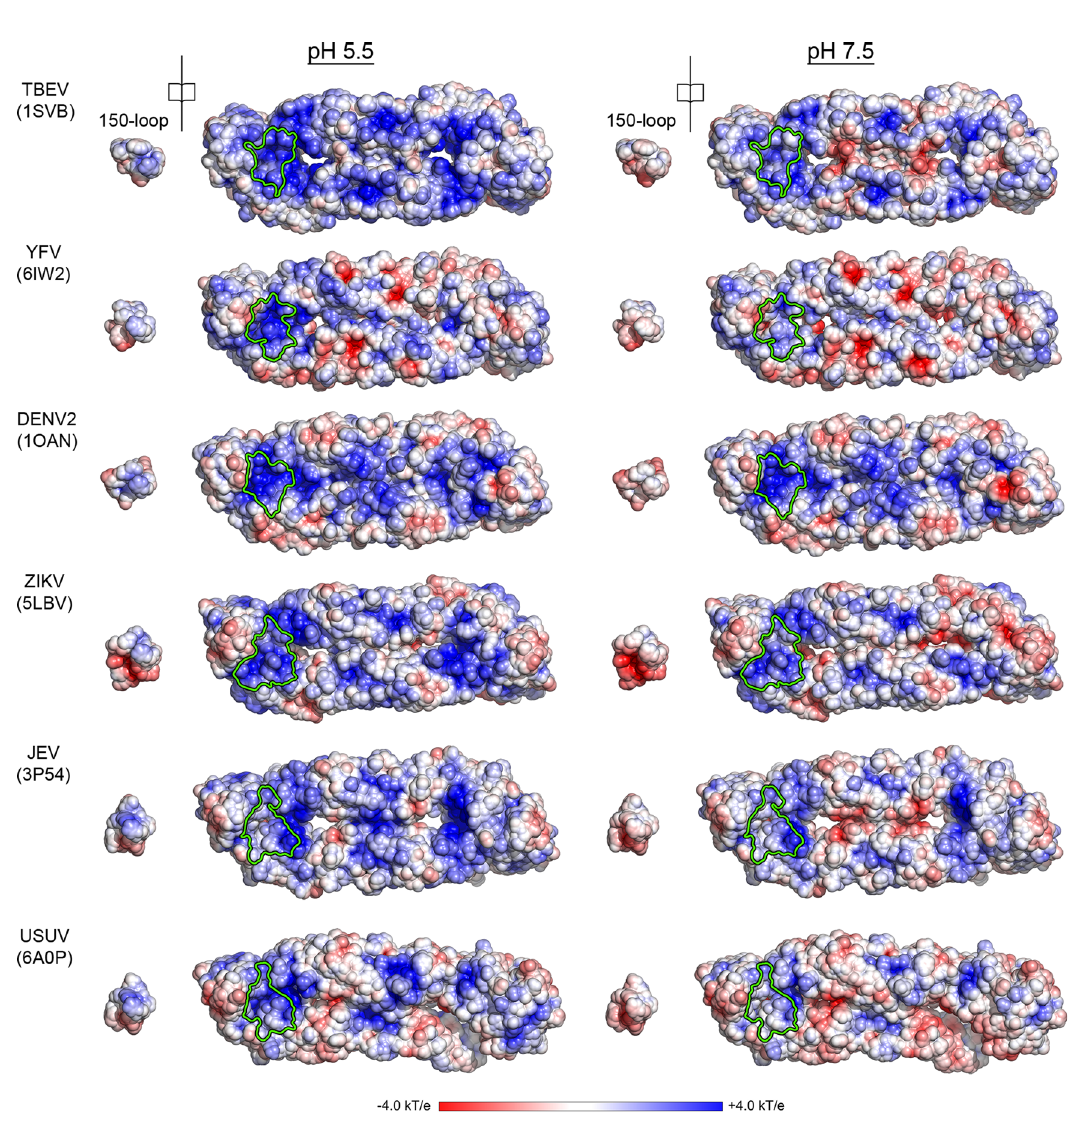
Fig. 5 Speci fi c protonation of the 150-loop at acid pH across fl aviviruses. The various X-ray structures of the fl avivirus sE dimer shown were determined from crystals grown at pH above 7.5. They are labeled with the corresponding virus and PDB code, and shown in surface representation colored according to their surface electrostatic potential (as indicated in the color code bar) calculated at pH 5.5 (left panels) and pH 7.5 (right panels). The 150-loop was extracted from the left half of the sE dimer and is shown in an open book representation to show the protonation state of its buried surface (i.e., the lid ’ s inner surface) at pH 5.5 and 7.5. The matching surface buried by the lid in the sE dimer is outlined in green. This surface includes the authentic N-terminus of E (see also Supplementary Fig.